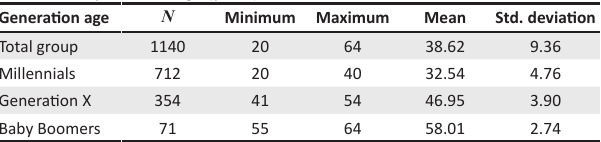
TABLE 2: Respondents’ age (years).